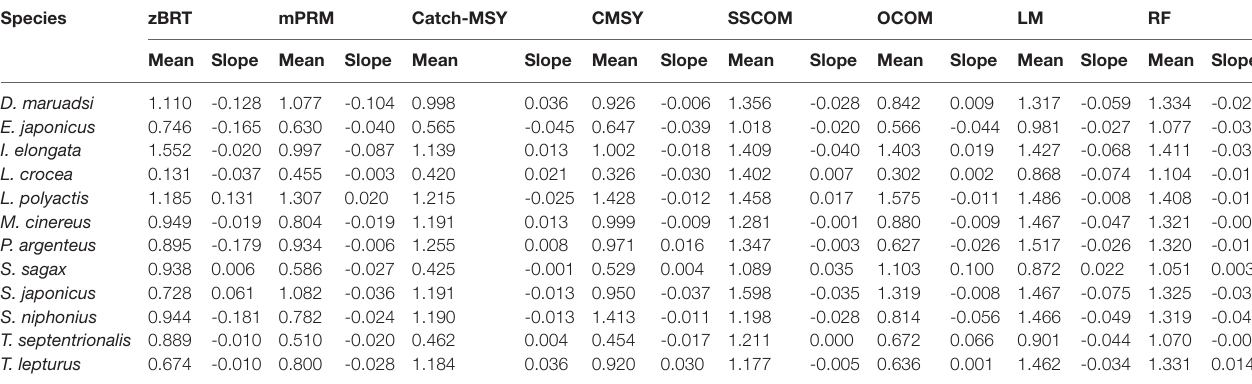
TABLE 2 | Individual COMs and ensemble model estimates of the mean and slope of B/B MSY over the last 5 years of time series. Species